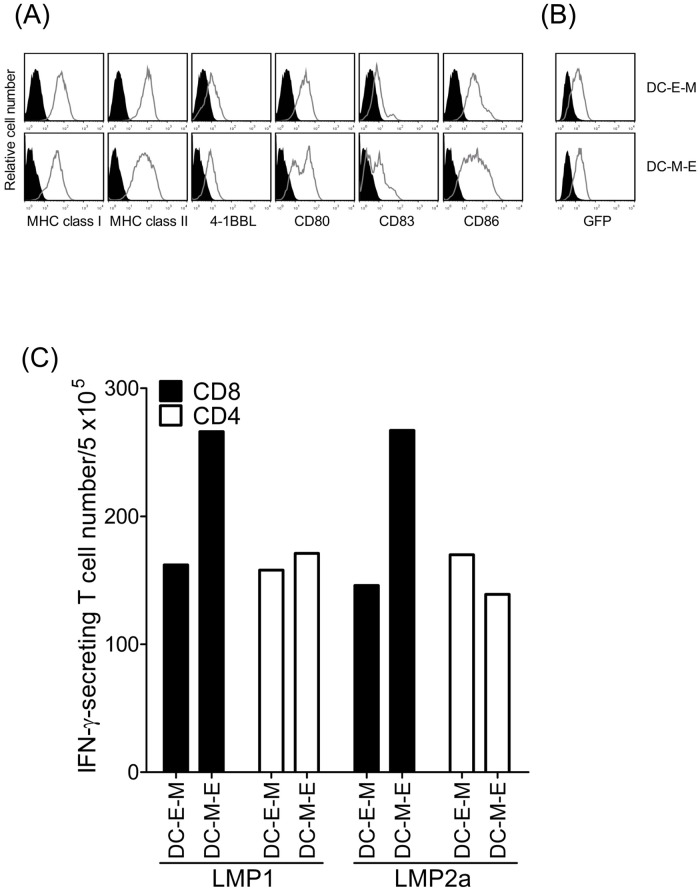
The immunophenotype and stimulatory capacity of GFP mRNA-transfected DCs before (DC-E-M) or after (DC-M-E) maturation.(A, B) Comparison of expression levels of HLA class I and II molecules, 4-1BBL, CD80, CD83, CD86, and GFP in DCs by flow cytometric analysis using specific mAbs. Histograms compare binding of specific mAbs (gray) and control (black). (C) Stimulatory capacity of DCs transfected by electroporation before or after a 24-h maturation period with 20 μg LMP1 or LMP2a mRNA. This experiments were repeated in #18 donor.